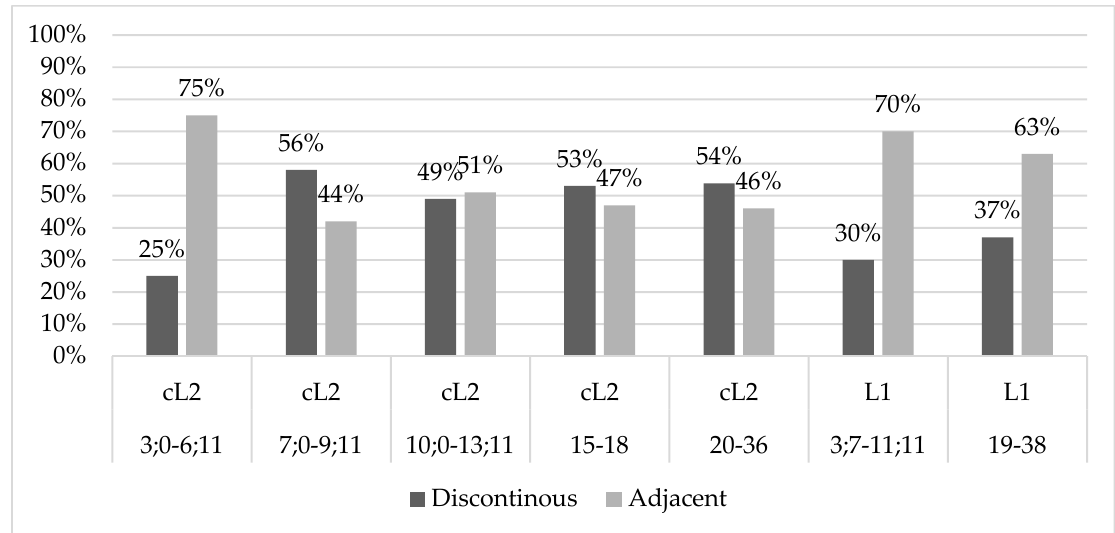
Figure 4. Relative frequency of discontinuous vs. adjacent word order pattern in early sequential bilinguals (cL2) and monolinguals (L1).